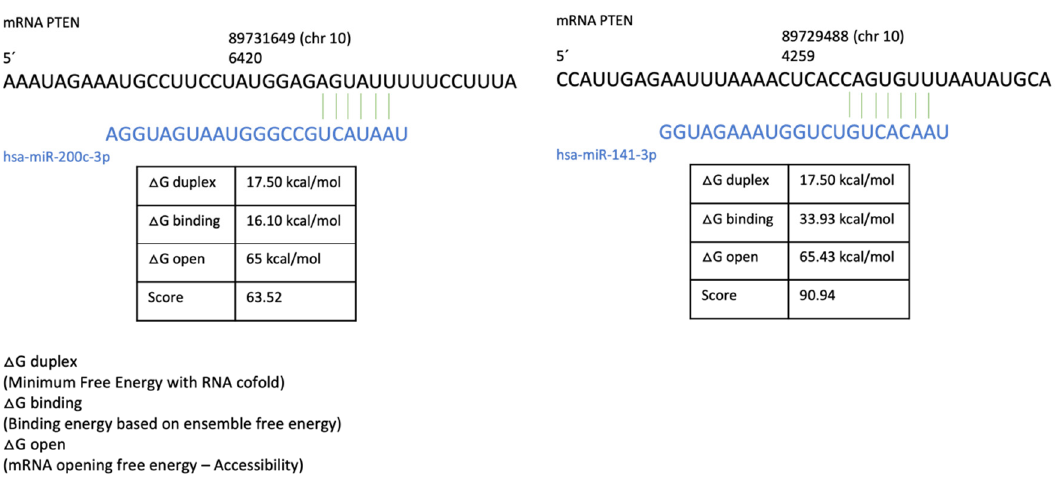
Figure 8. Comprehensive prediction of PETEN repression by miR-200c and miR-141 simulated in miRmap.